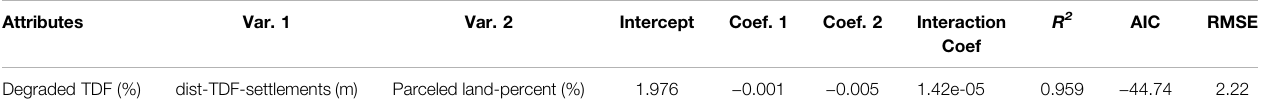
R 2 AIC RMSE Coef